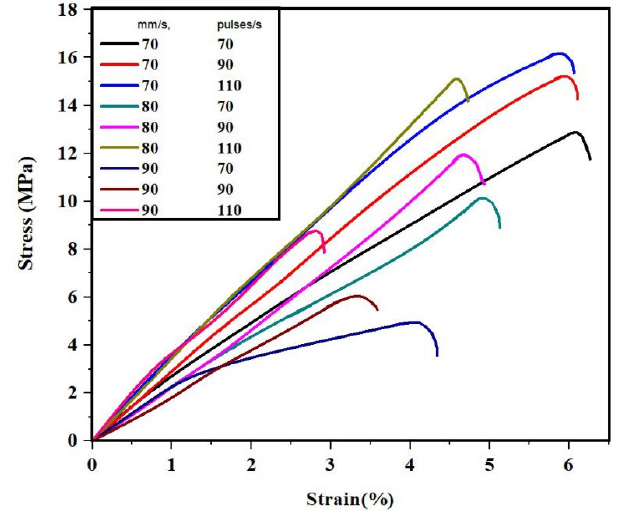
Figure 5. Stress-strain graph for the various print parameters.